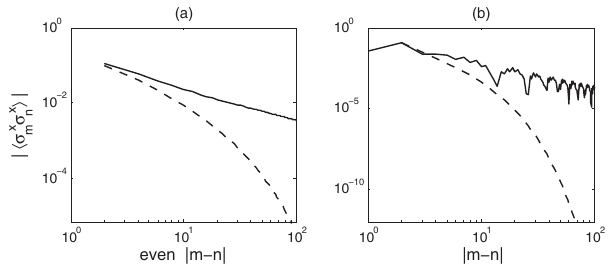
FIG. 7. Correlation functions for J 0 ¼ 0 . 13 γ (solid line) and J 0 ¼ 0 . 12 γ (dashed line) for (a) J ¼ 0 . 1 γ and (b) J ¼ 0 . Panel (b) shows only even distances for J 0 ¼ 0 . 12 γ .